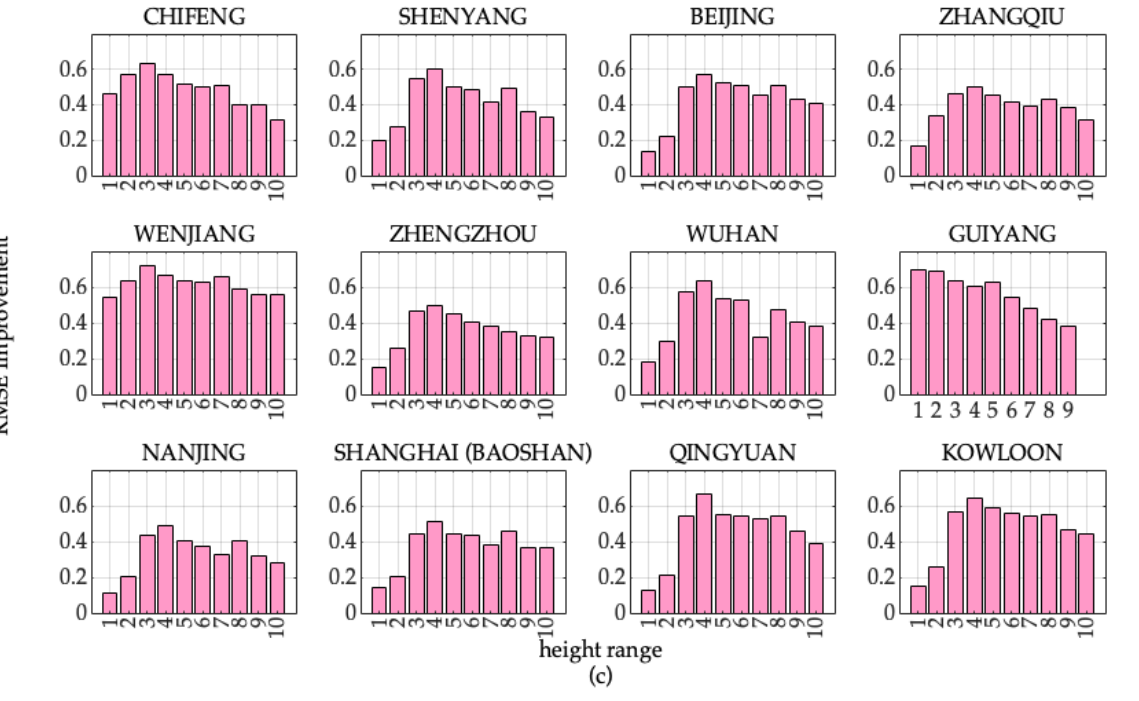
Figure 8. Annual biases ( a ) and RMSEs ( b ) of ρ wm and ρ wH resulting from the two models and ρ w from height ranges 1 to 10 at each of the 12 stations; ( c ) Improvement ratio of annual RMSE of ρ wm relative to that of ρ wH . Circles and diamonds denote the results of the exponential model and the new model, respectively.